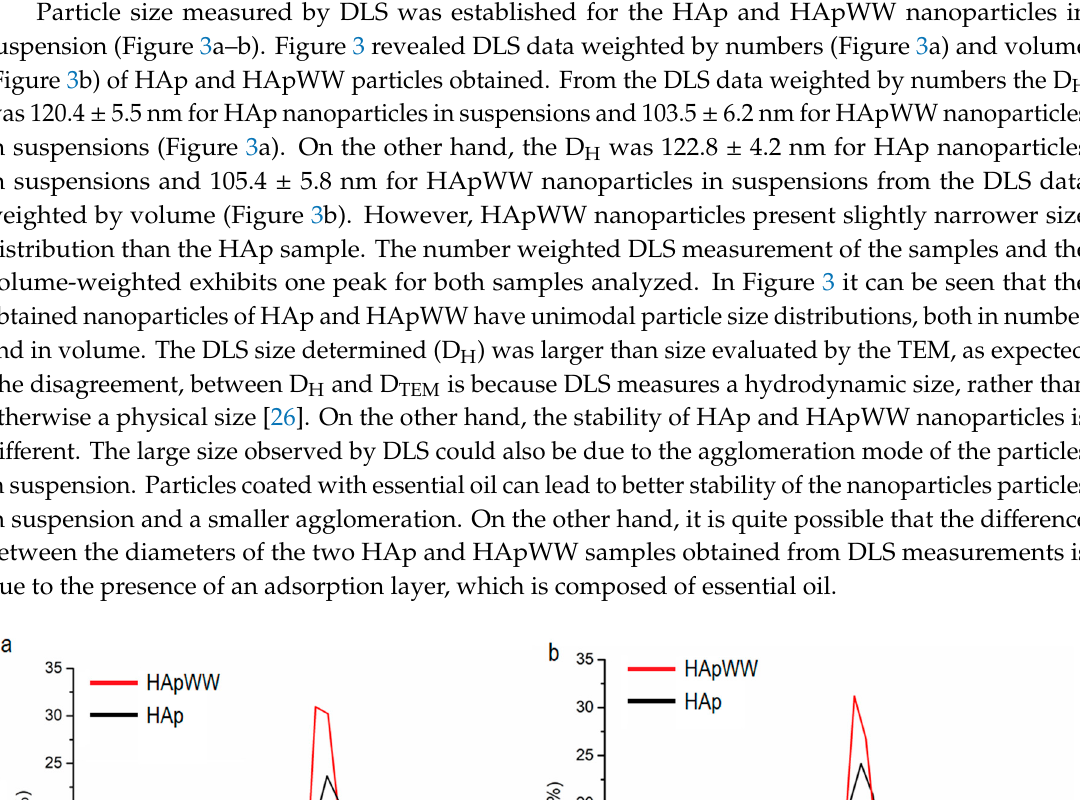
Figure 2. TEM image of HAp ( a ) and HApWW ( c ) nanoparticles. Distribution of HAp ( b ) and HApWW ( d ) nanoparticles obtained from TEM images.